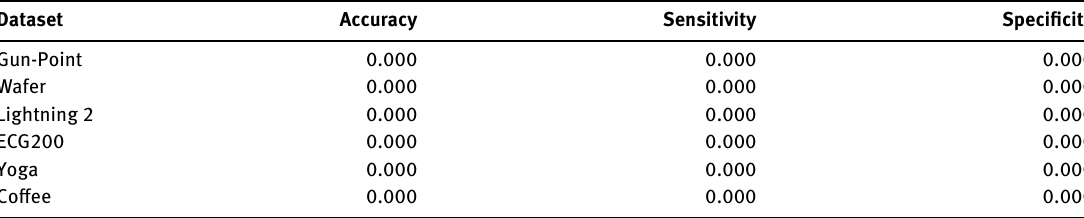
Table 6: p-Values of t-Test for GWO vs. FA for Accuracy, Sensitivity, and Specificity.